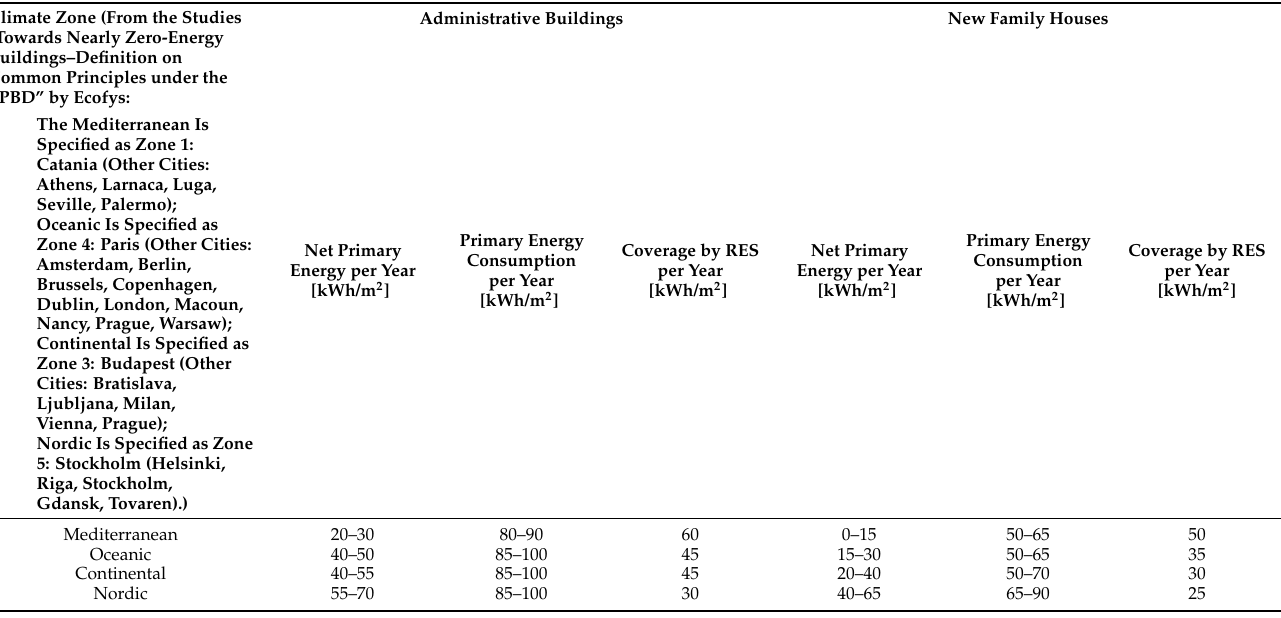
Table 1. Reference values for EPB and NZEB for countries in different EU climate zones EU (Commis- sion’s Recommendation (EU) 2016/1318 of 29 July 2016 on guidelines to promote nearly zero-energy buildings and best practices to ensure that all new buildings are nearly zero energy by 2020).